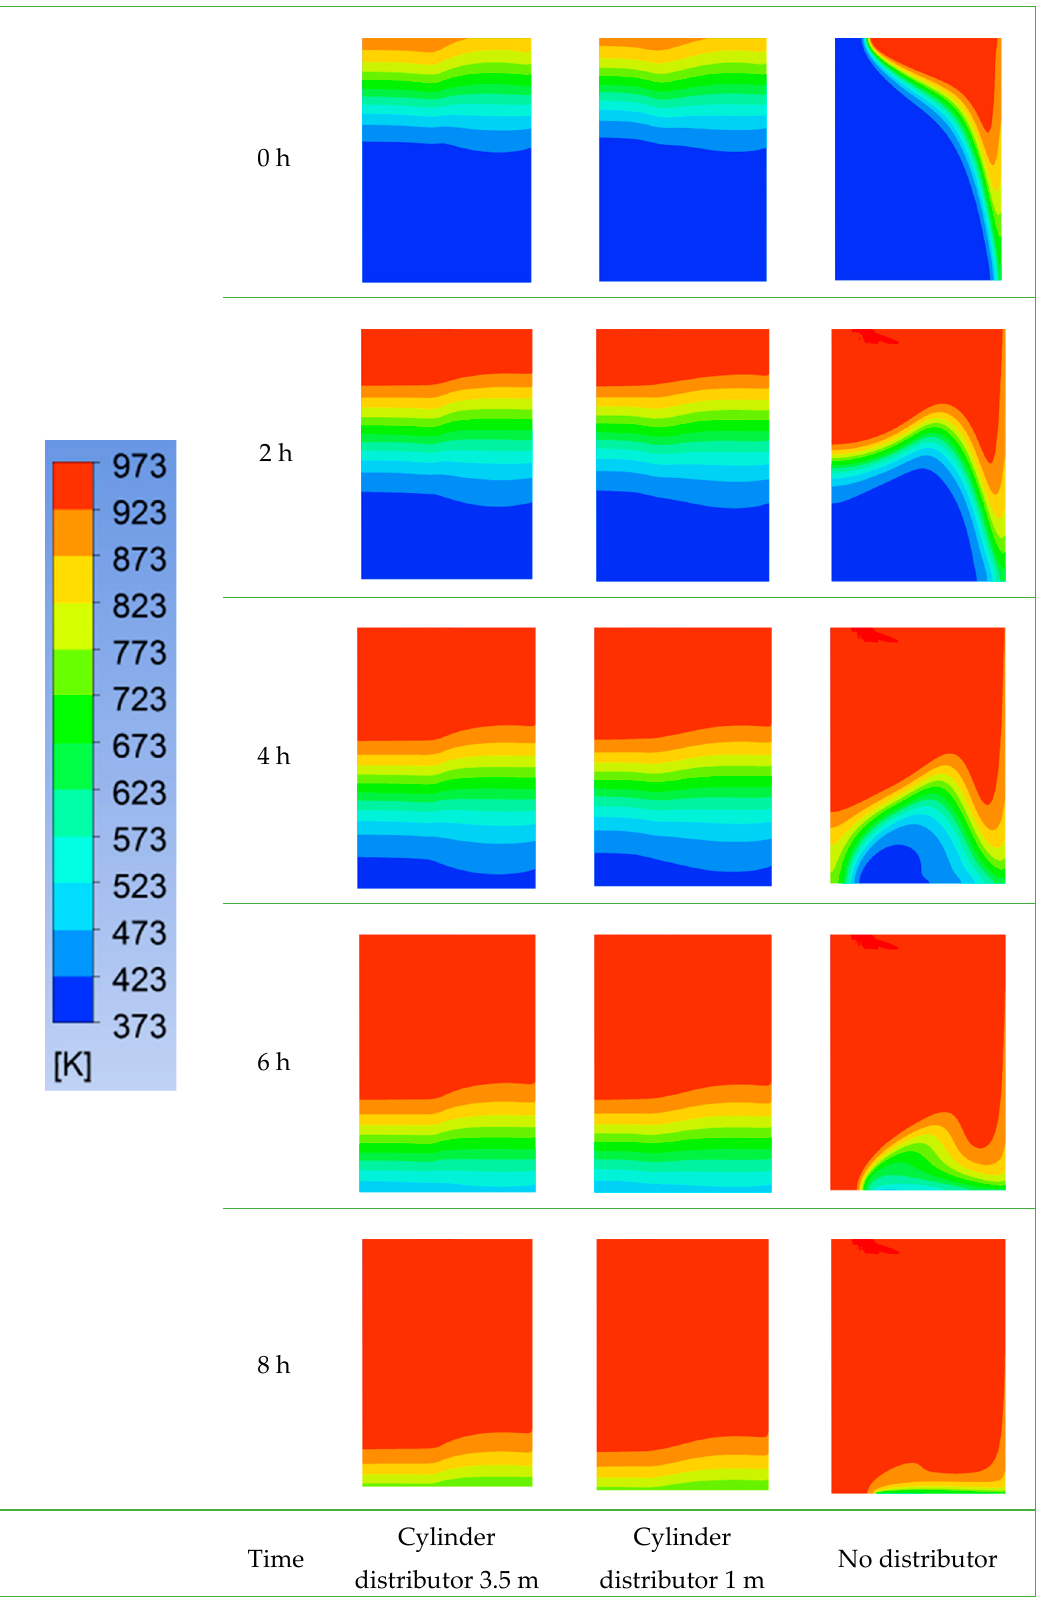
Figure 13. Inventory temperature profiles over storage length and radius after several hours of charging.